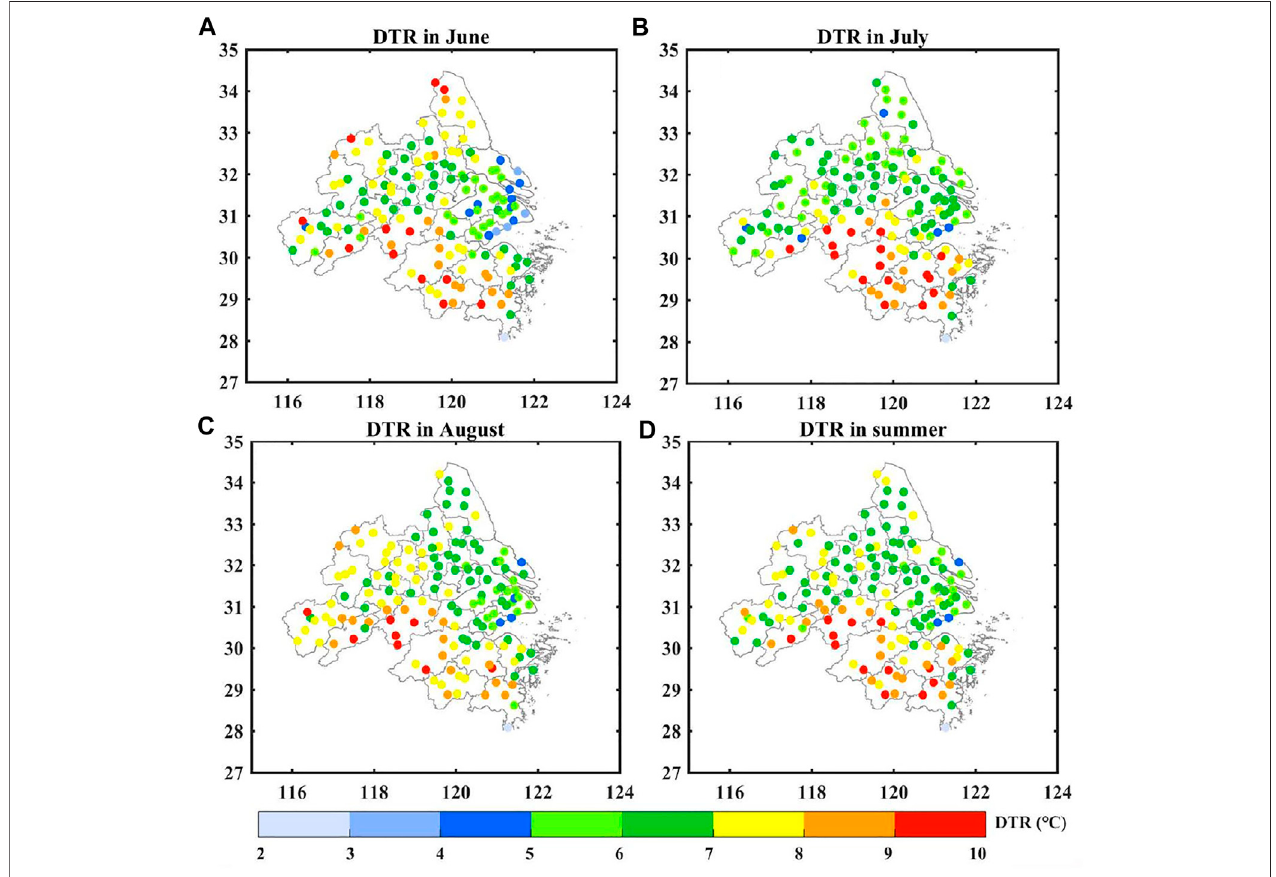
FIGURE4| SpatialdistributionofthemeanDiurnalTemperatureRange(DTR)intheurbanagglomerationoftheYangtzeRiverDeltaregioninsummer: (A) June, (B) July, (C) August, and (D) June – August.